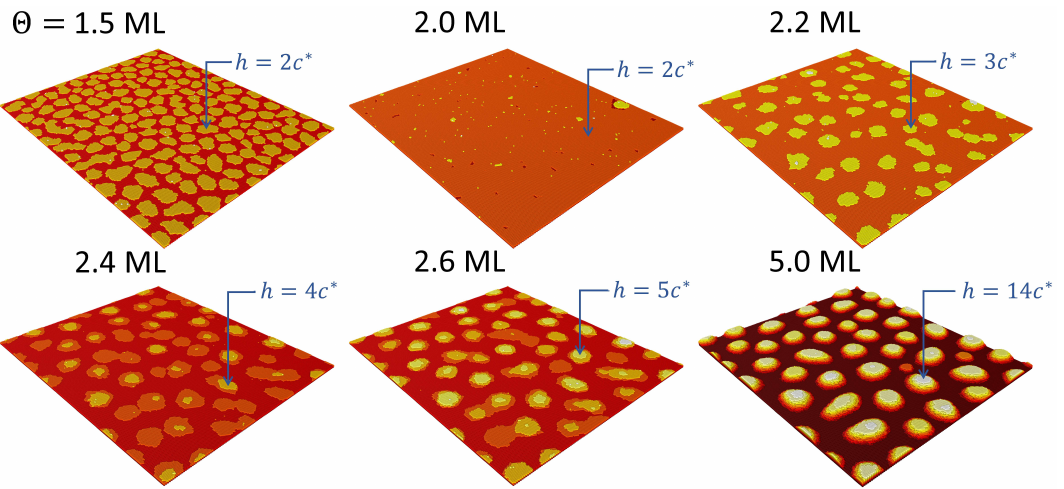
Figure 4. Simulation of the process of growth of 5 ML of GaN on AlN. The various panels show the GaN surface morphology at different instants (corresponding to the specified values of the GaN coverage Θ ). The color scale indicating the discrete height is independently chosen in each panel, but the corresponding maximum height is specified in every case.